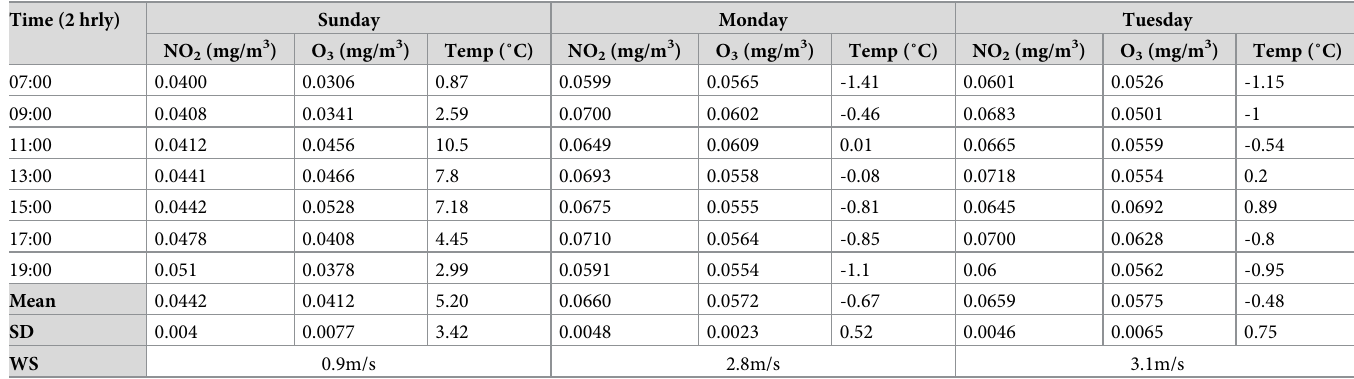
Table 1. Daily NO 2 and O 3 exposure levels.